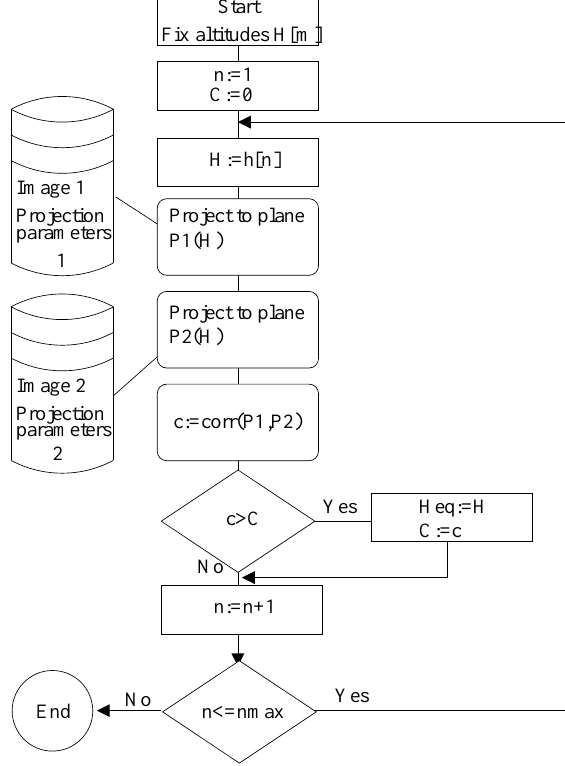
Fig. 2. Flowchart of the algorithm for automatic determination of the equivalent altitude of best matching, H eq . The designa- tions Image 1 and Image 2 can refer to either full images or sub- blocks/regions of interest. In the present version the altitudes of mapping are